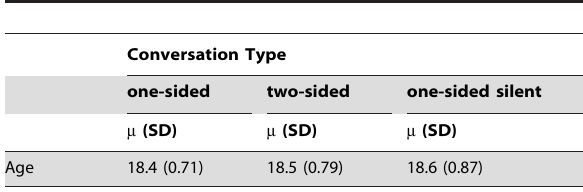
Table 2. Average age for participants in the one-sided, two- sided, and one-sided with silent confederate conditions.